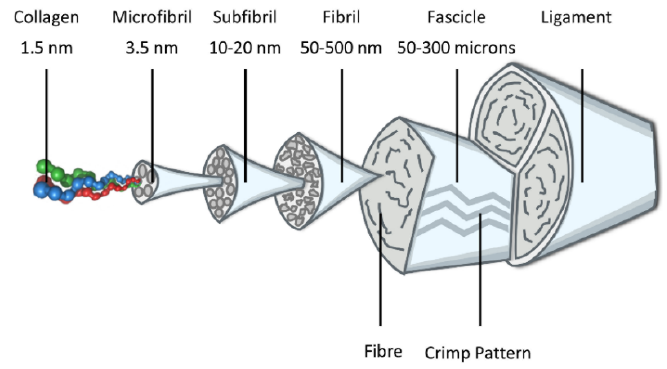
Figure 2. Schematic drawing of the multi-unit hierarchical structure of the ligament. The cells in the ACL are interspersed between the collagen fibril bundles along the